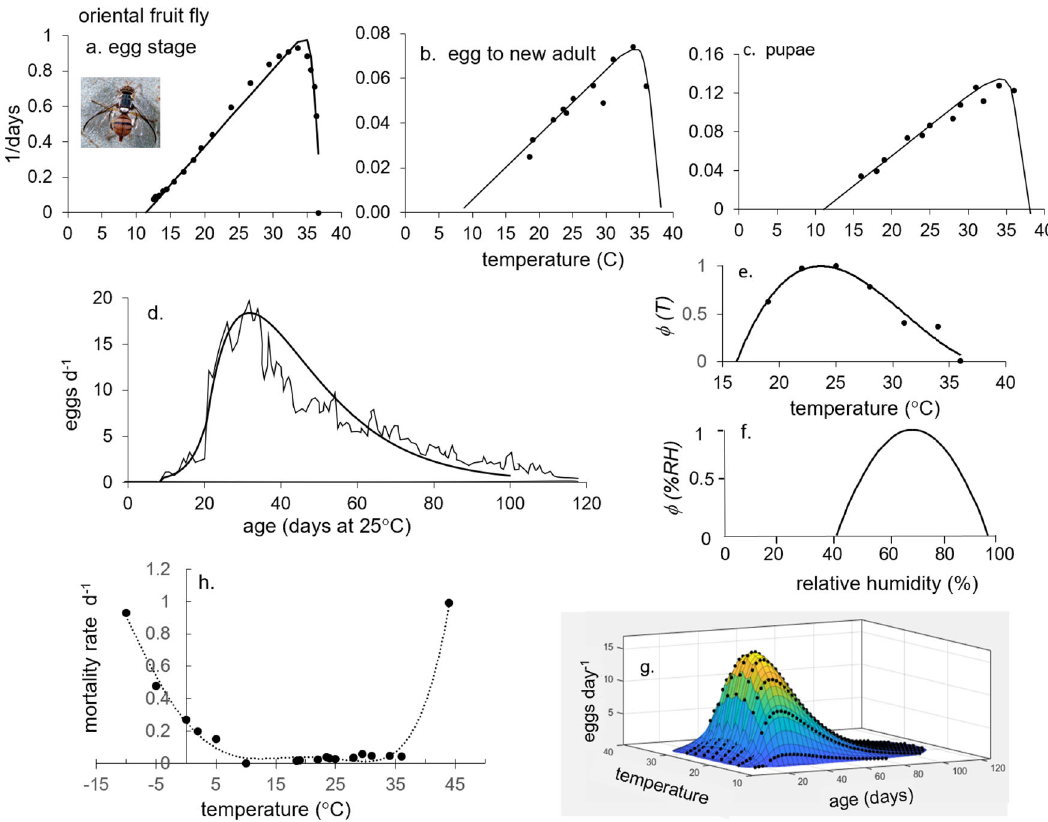
Fig. 7 Biodemographic functions for oriental fruit fl y. a – c Rates of development of the egg, egg to new adult, and pupal stages respectively 75,78 – 80,97,98 , d per capita fecundity pro fi le on age in days at 25 °C 98 , and the inferred scalars for reproduction on e temperature ( ϕ (T) ) 79,80,89 and f relative humidity ( ϕ (RH) ) 103 , g 3-D age speci fi c fecundity pro fi les corrected for the effects of ϕ (T) , and h mortality rates for all life stages 46,95,99 – 101 . The clip of oriental fruit fl y is by Jack Kelly Clark, University of California Statewide IPM Program.